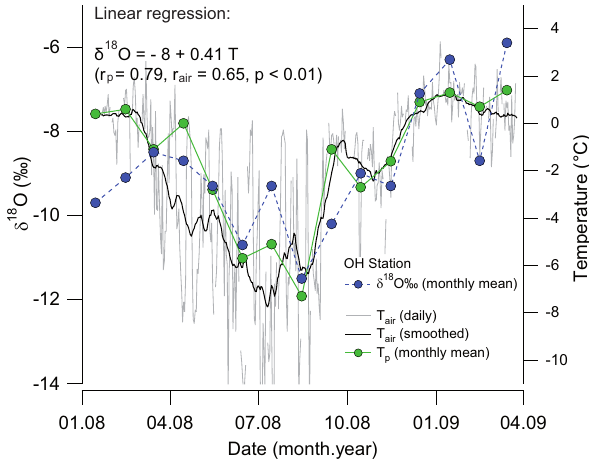
Fig. 7. Mean monthly δ 18 O values (blue dots) of precipitation samples collected at O’Higgins station. Also shown are data of mean monthly air temperature during precipitation days only ( T p , green dots), daily record ( T air , light grey) and smoothed record T air (30 day smoothing, black line) at this station. A clear seasonal variability of δ 18 O is observed, linear regression of the δ 18 O and T correlation is presented in the